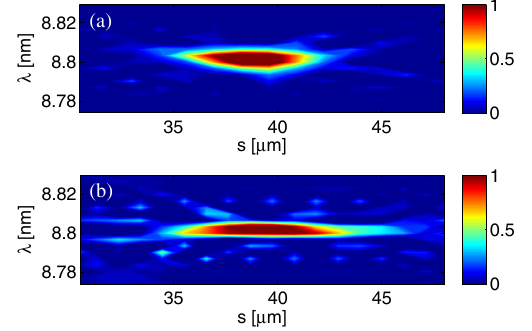
FIG. 16. Wigner distributions of 30th harmonic radiation pulses at the very beginning of the radiator of EEHG for the 80 fs seed laser pulses with flat phase (a) and quadratic phase (b).